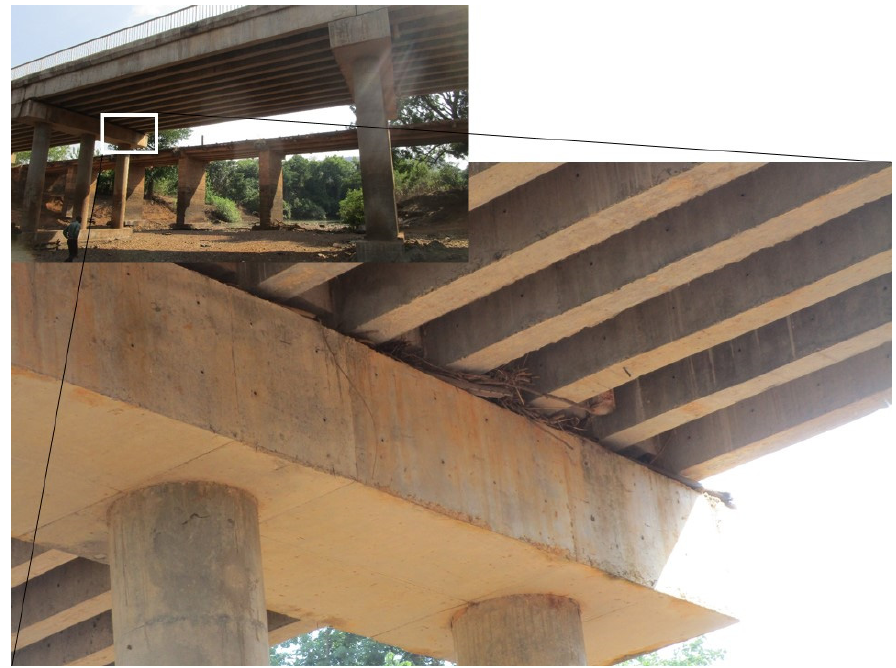
Figure 16. Pieces of branches blocked under the bridge deck of the new bridge of Komba on the Komba River (Upper Koliba/Corubal basin) after the flood of 2018. On the small picture: the new (2012) and, in the back, the ancient bridge (1950s).